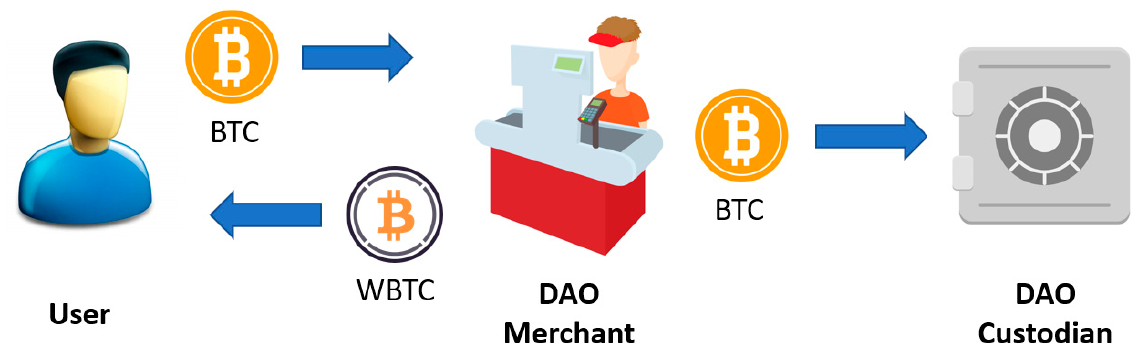
Figure 4. WBTC issuing procedure.